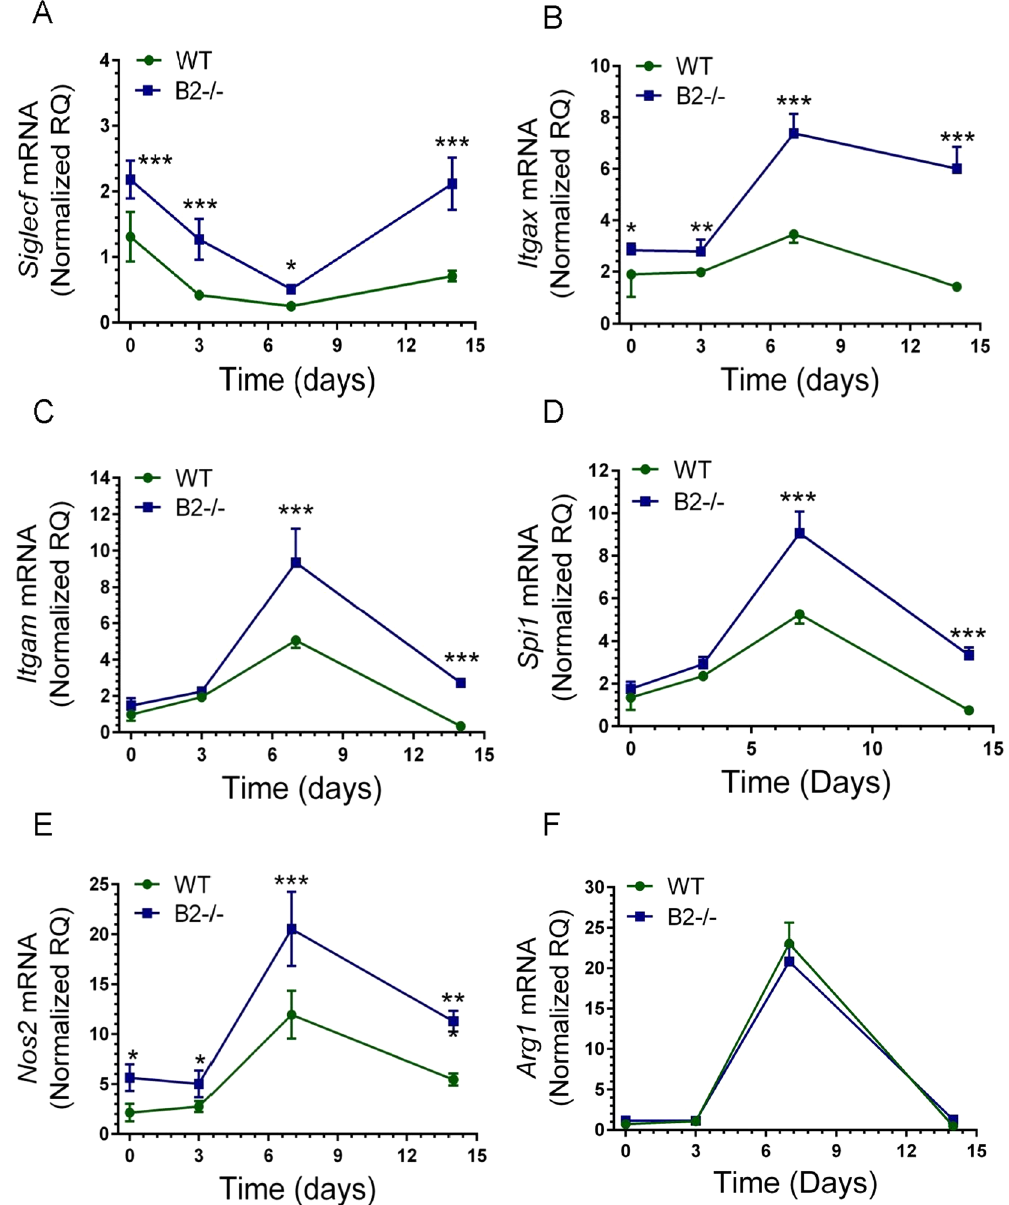
Figure 7. Endophilin B2 attenuates expression of macrophage differentiation and activation genes. The mRNA levels of ( A ) Siglecf , ( B ) Itgax , ( C ) Itgam , and ( D ) Spi1 , ( E ) Nos2 , and ( F ) Arg1 in WT and B2 − / − mice were quantitated by qRT-PCR in total lung. Data were normalized to 18S rRNA and expressed as relative quantity (RQ) compared to WT uninfected control treated with DPBS vehicle. *** p < 0.00001, ** p < 0.001, * p < 0.05 (for WT n = 4, 9, 8, and 6 and B2 − / − n = 3, 7, 8, and 6 at t = 0, 3, 7, and 14 days; the vehicle treated mice are plotted as t = 0. Data ± SEM are from 2 independent